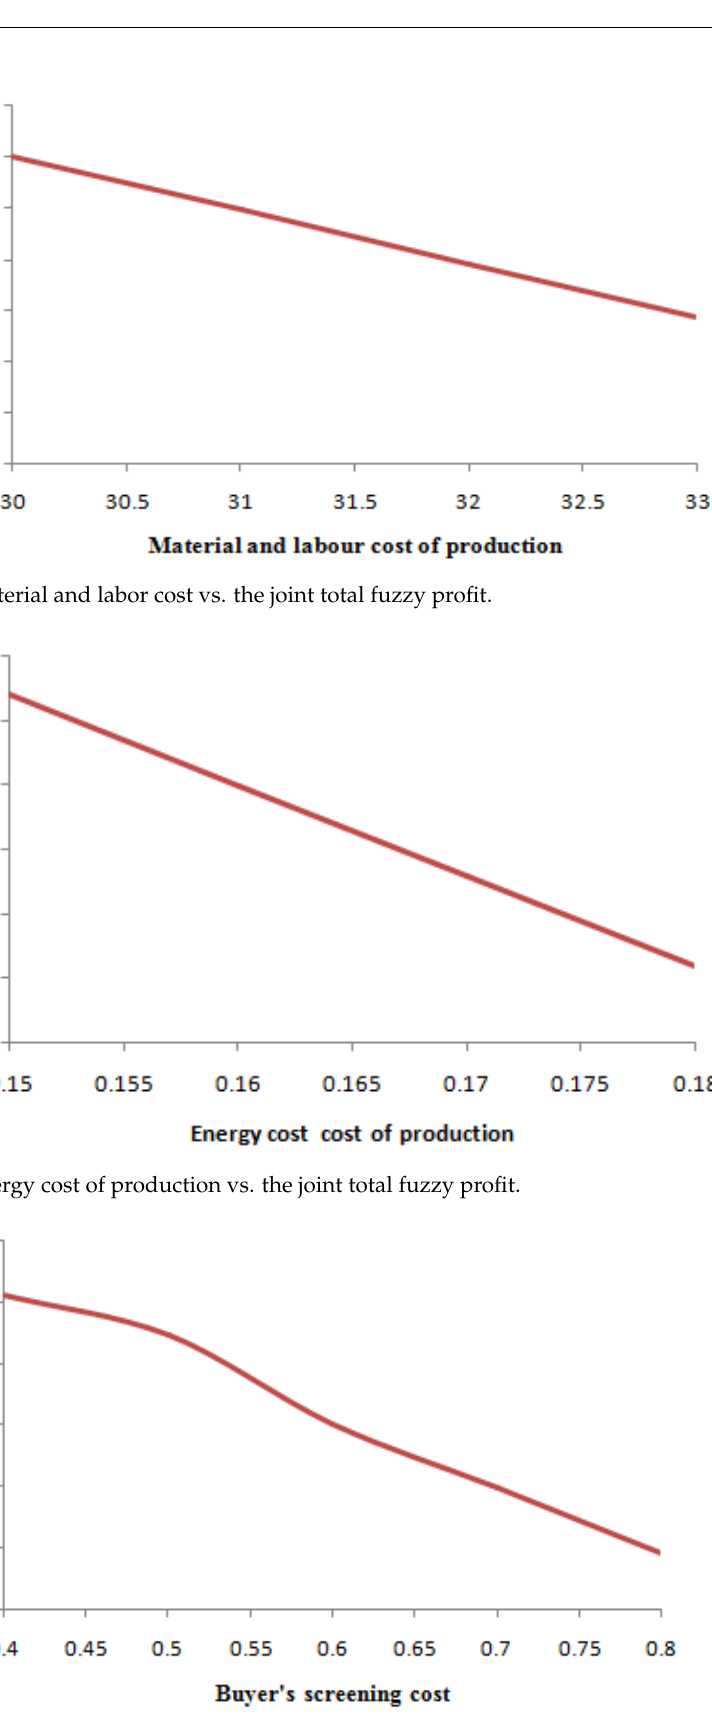
28 of 36 Figure 13. The carbon emission cost due to disposal vs. the total fuzzy profit. Figure 14. The carbon emission cost due to production vs total fuzzy profit